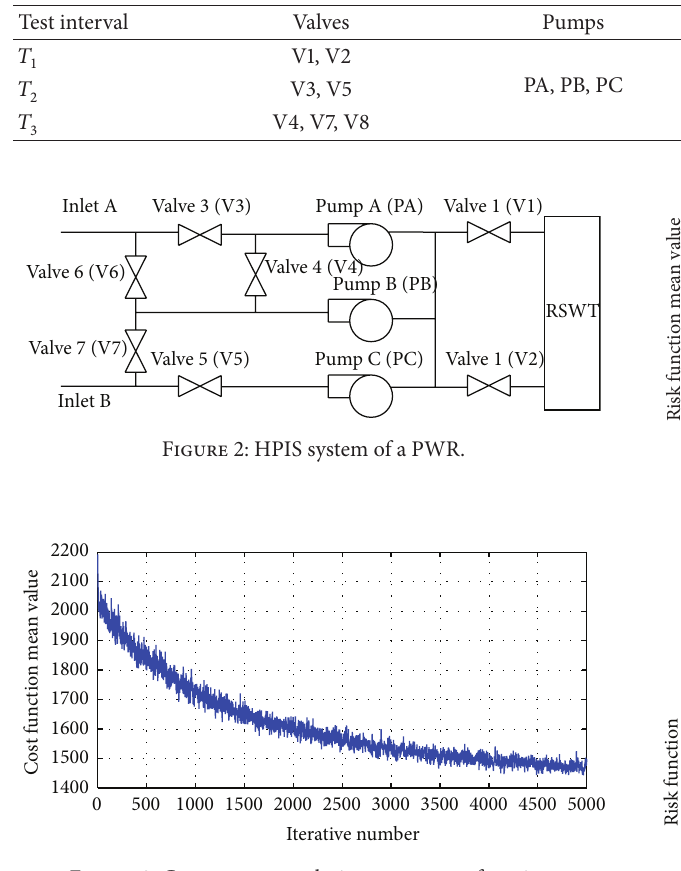
Figure 3: Convergence evolution versus cost function.